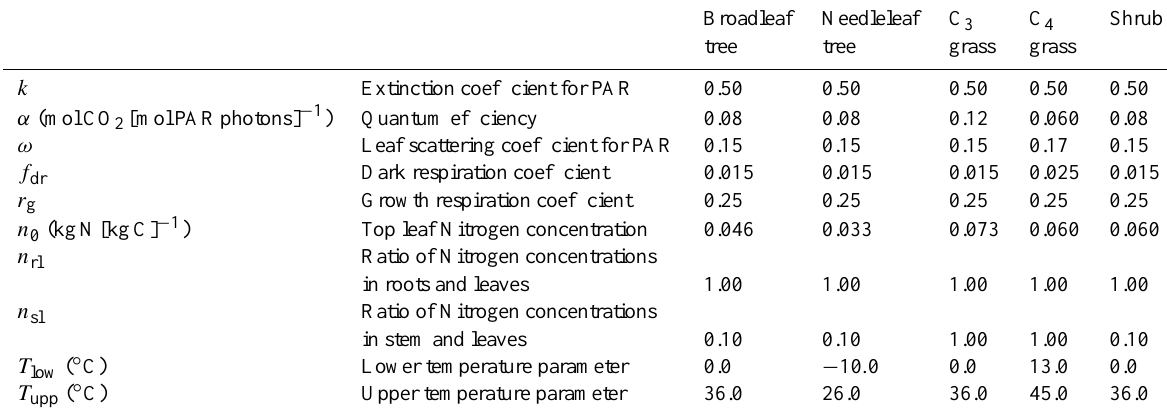
Table 2. Default values of PFT-specific parameters for leaf biochemistry and photosynthesis.